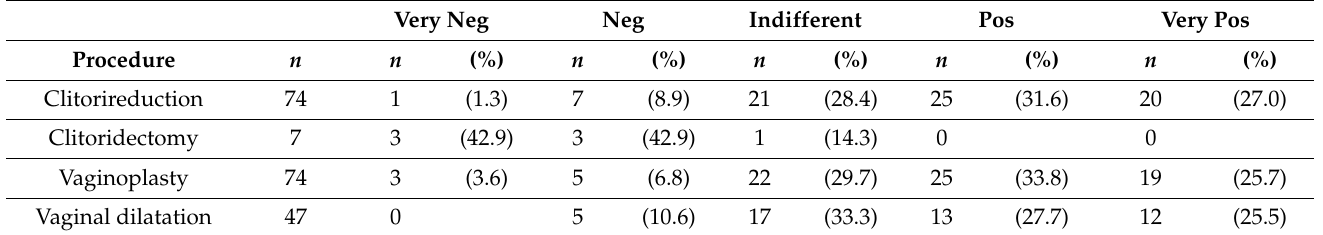
Table 5. Influence of surgeries and vaginal dilatation on the lives of women with 46,XX-CAH.